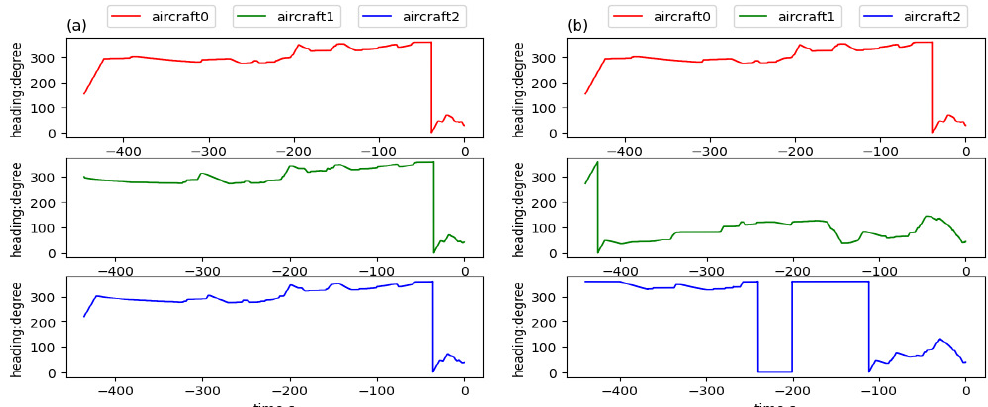
Figure 16. Headings of aircraft trained in team aircraft guidance: ( a ) three aircraft starting in the same aerospace, flying to the aimed for 4D waypoints, respectively, and ( b ) three aircraft starting in different aerospaces, flying to the aimed for 4D waypoints, respectively.